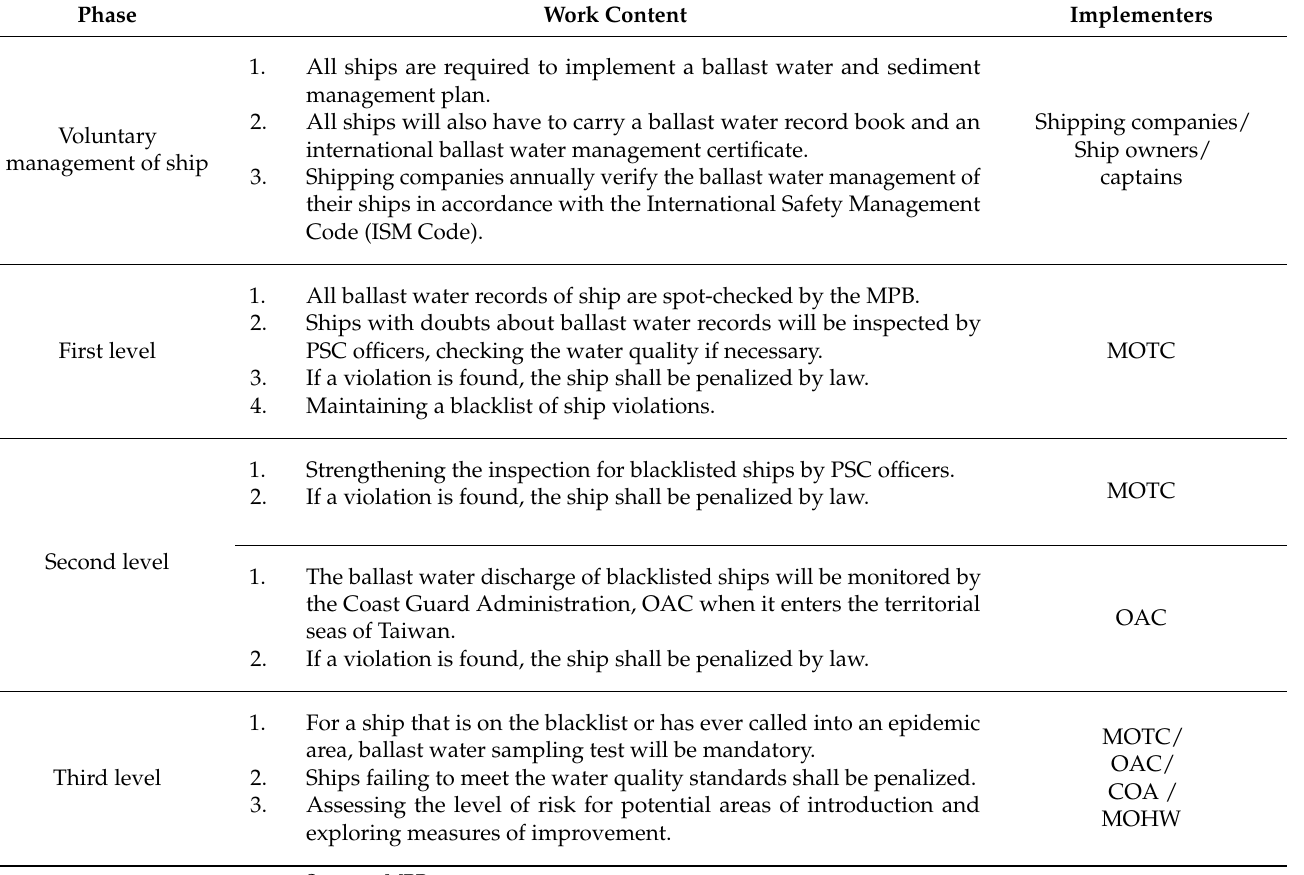
Table 3. Ballast water management: The 3 + 1 hierarchical PSC procedure in Taiwan. Work Content